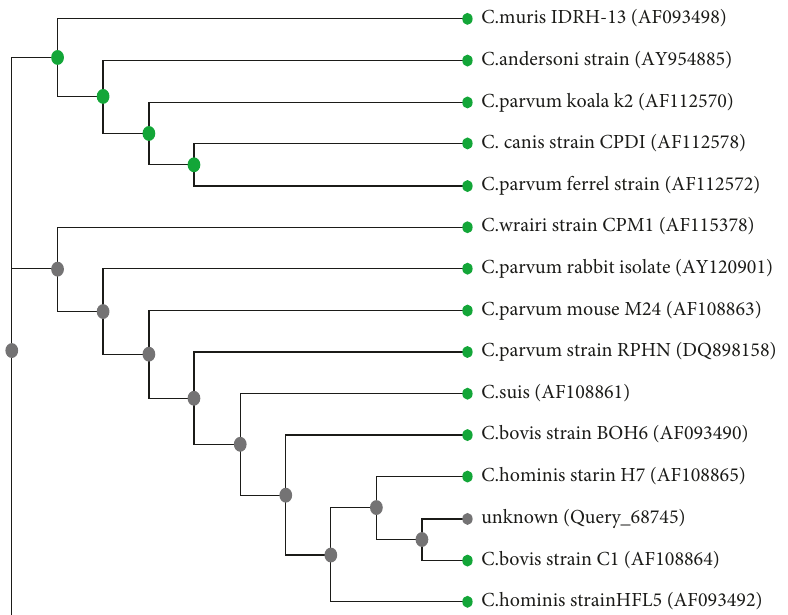
Figure 7: Phylogenetic maximum likelihood tree of the 18SSU-rRNA gene sequences with 1000 repeats Bootstrap. The sequence of this study (Query_68745) was aligned with 14 other sequences of human and animal isolates of Cryptosporidium species from GenBank.